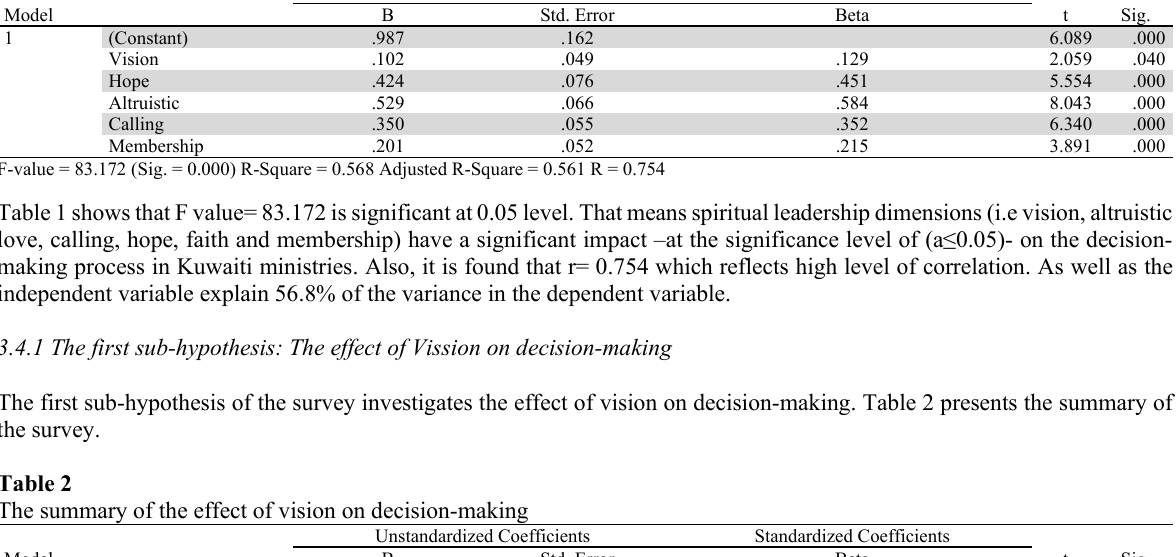
The result of testing the main hypothesis Model